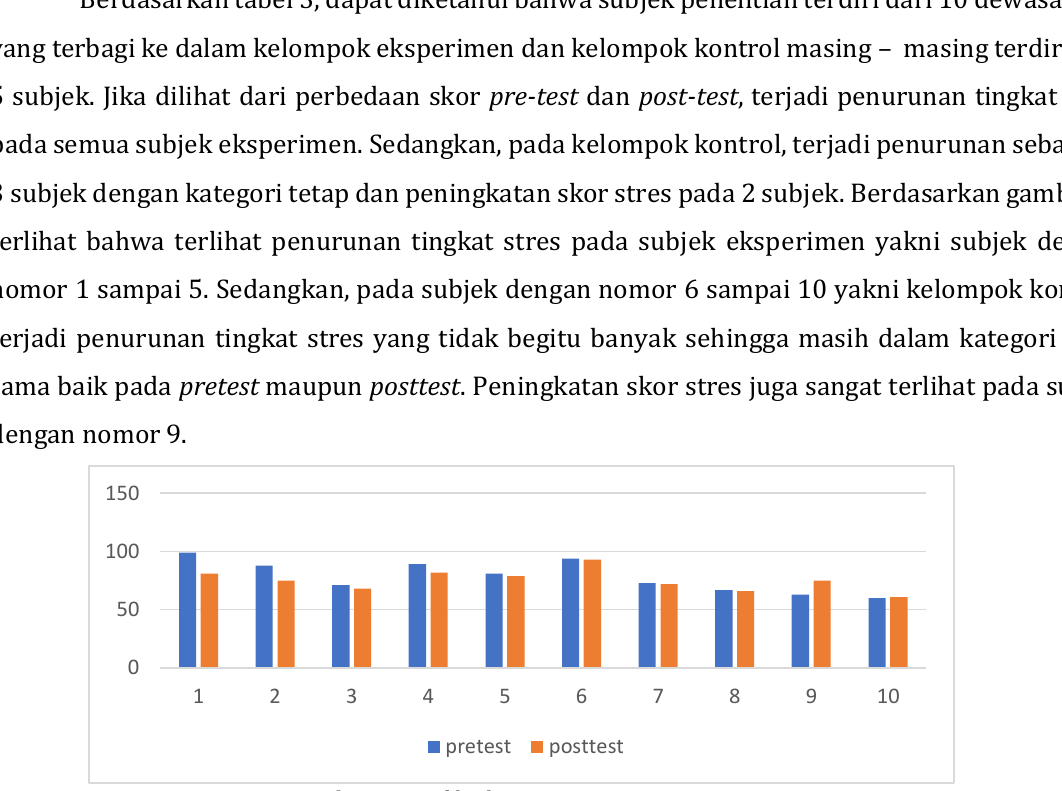
Gambar 1. Grafik Skor Pre-test Post-test